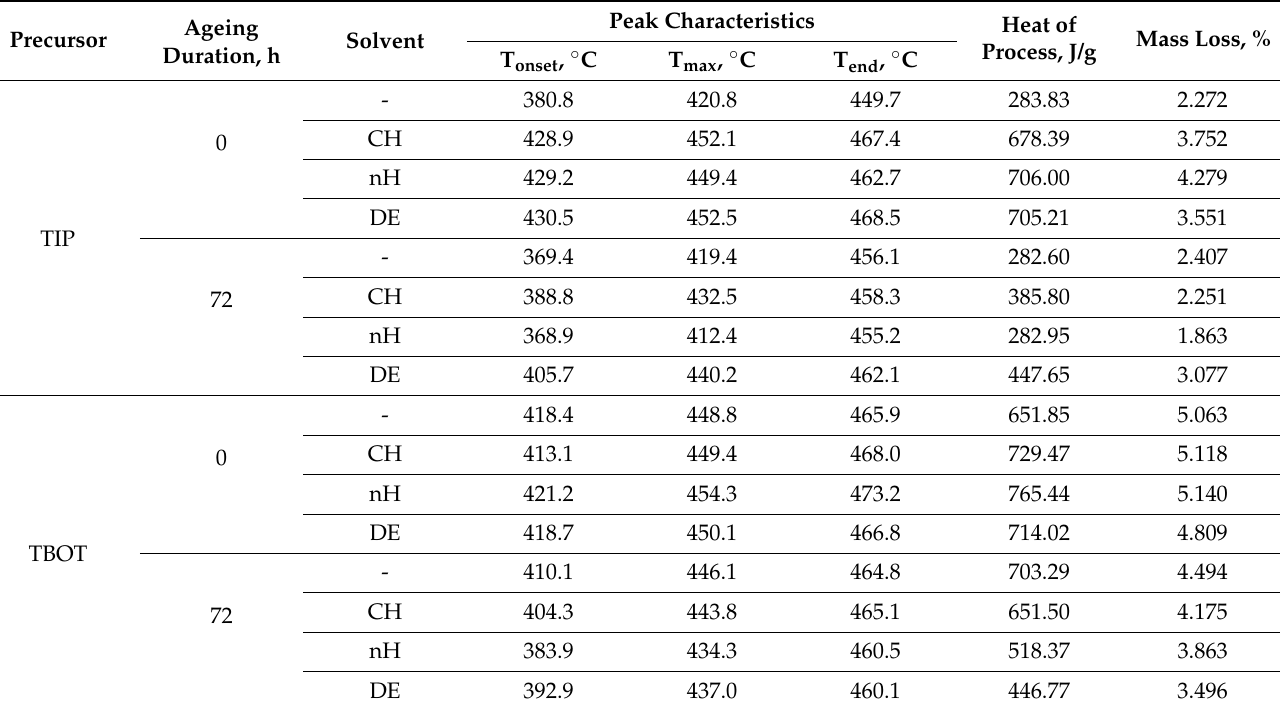
Table 2. Details of STA curves that are typical for TiO 2 aerogel anatase phase